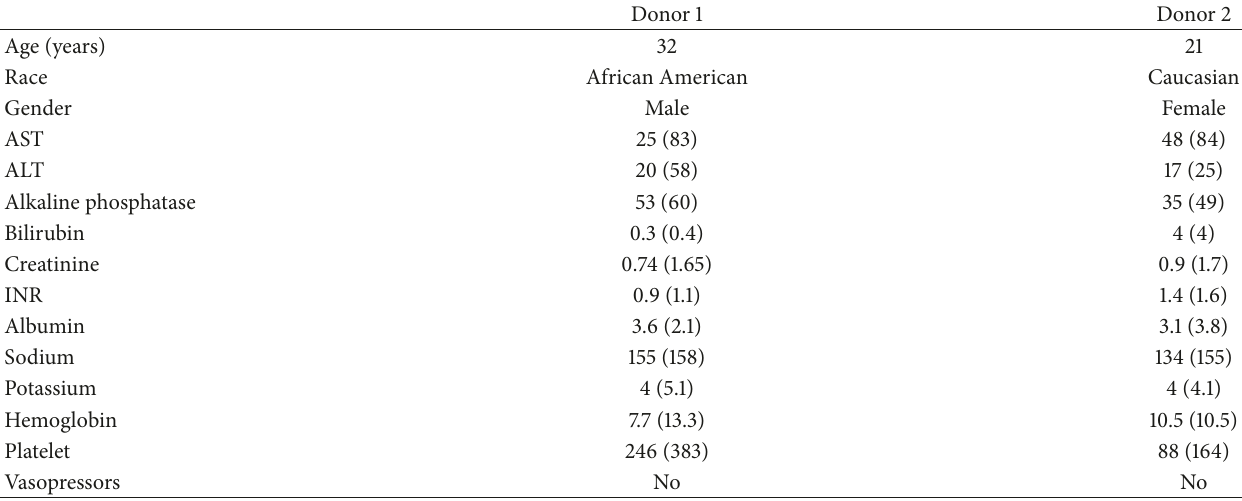
Table 1: Demographics and lab work for both donors showing terminal value and peak value in